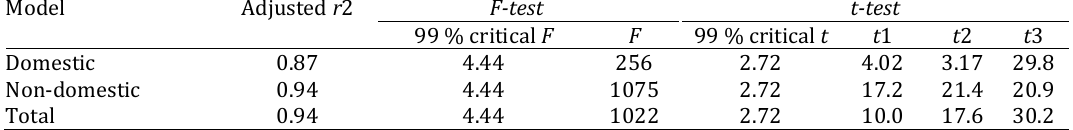
Table 2: The testing results of the multiple linear regression model on a significance